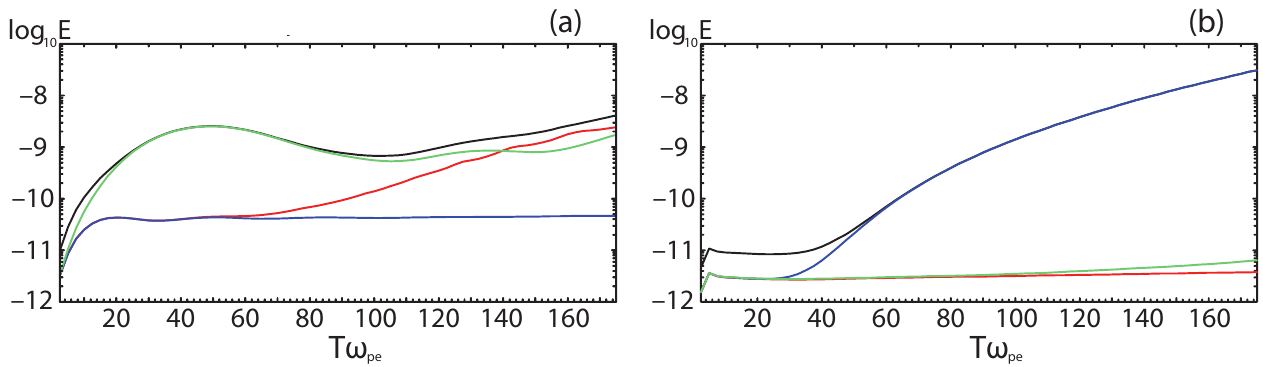
Fig. 5. Evolution of electric (a) and magnetic (b) field energies for the core jet with with γ j = 15 and stationary sheath plasma for the case with the mass ration m i /m e = 1836. Panel (a) shows the evolution of the total electric field energy (black), E z (green), E x (red), and E y (blue). The evolution of the total magnetic field energy (black), B y (blue), B z (green), and B x (red) is plotted in panel (b).